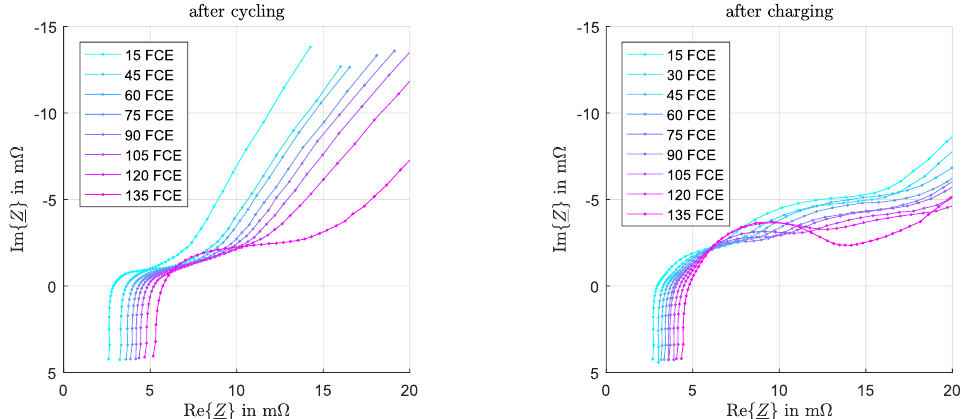
Figure A1. The impedance spectra recorded without superimposed DC-currents during hard AK3.4 on TC 1 are presented. On the left side, the spectra are shown, which were recorded during the resting phase after cycling. On the right side, the spectra recorded after charging are presented.